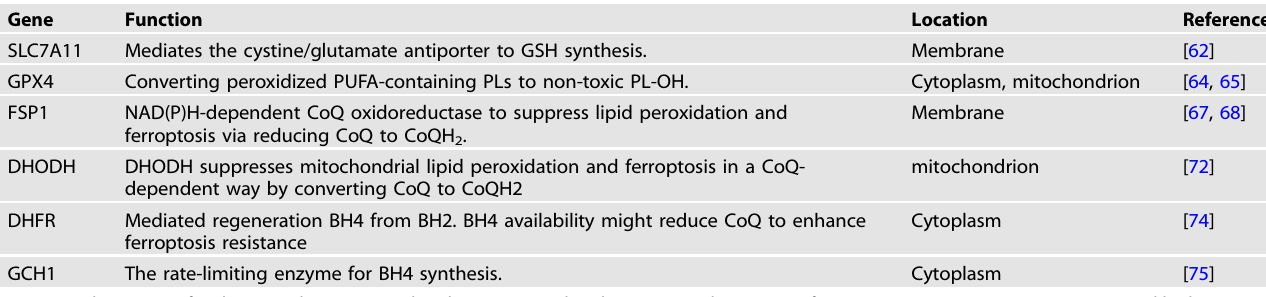
Table 1. Functions of lipid peroxidation-related genes and their promotion or resistance of ferroptosis. Gene Function Promote or resist Reference(s) ferroptosis ACSL4 Addition of CoA to free long-chain PUFAs Promote [41] ACSL3 Catalyze MUFAs to fatty acyl-CoAs resist ACSL1 Accumulation of α ESA in TAGs Promote [43] LPCAT3 Catalyzes the insertion of acylated AA into membrane phospholipids Promote [47] ALOX Enhance AA- or AdA-containing diacylated PEs production Promote [50, 51] FAR1 Converting SFA to fatty alcohol to synthesized PUFA-ePLs in Peroxisomes Promote [55, 56] iPLA2 β Eliminate peroxidized arachidonoyl-PE species resist [48, 49] Promote [57, 58] POR and CYB5R1 Transfer electrons from NAD(P)H to oxygen to generate H 2 O 2 to induce Fenton reaction and ferroptosis ACSL4 Long-chain acyl-coenzyme A synthase 4, ACSL3 Long-chain acyl-coenzyme A synthase 3, ACSL1 Long-chain acyl-coenzyme A synthase 1, PUFAs polyunsaturated fatty acids, MUFAs monounsaturated fatty acids, LPCAT3 lysophosphatidylcholine acyltransferase 3, AA arachidonic acid, AdA adrenic acid, α ESA α -eleostearic acid, TAGs triacylglycerols, ALOX lipoxygenase, FAR1 Fatty acyl-CoA reductase 1, SFA saturated fatty acid, PUFA-ePLs polyunsaturated ether phospholipids, iPLA2 β Ca2 + -independent phospholipase A2 β , PE phosphatidylethanolamine, POR cytochrome P450 oxidoreductase, CYB5R1 cytochrome b5 reductase.